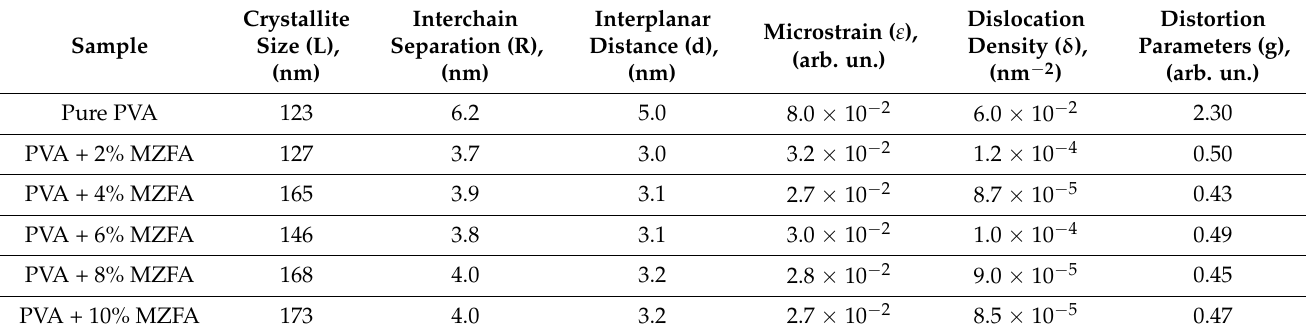
Table 2. The structural parameters of the polymer blend PVA/MZFA